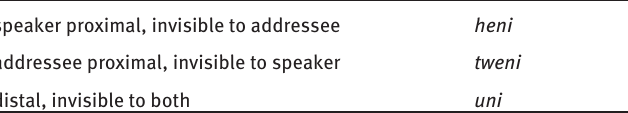
Table 2: Locative adverbial demonstratives (invisible) speaker proximal, invisible to addressee